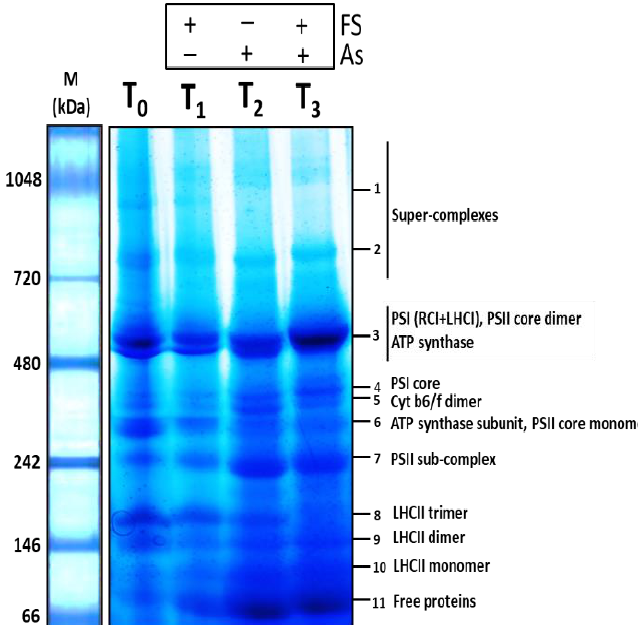
Figure 9. Blue-Native PAGE gel (1st dimension) showing bands representing thylakoidal membrane protein complexes in four treatment sets of B. juncea : T 0 (control), T 1 (+FeSO 4 ), T 2 (+As), T 3 (As+FeSO 4 ) at 14 DAT; M: Standard protein marker (kDa). As, Arsenic, FS, FeSO 4 .